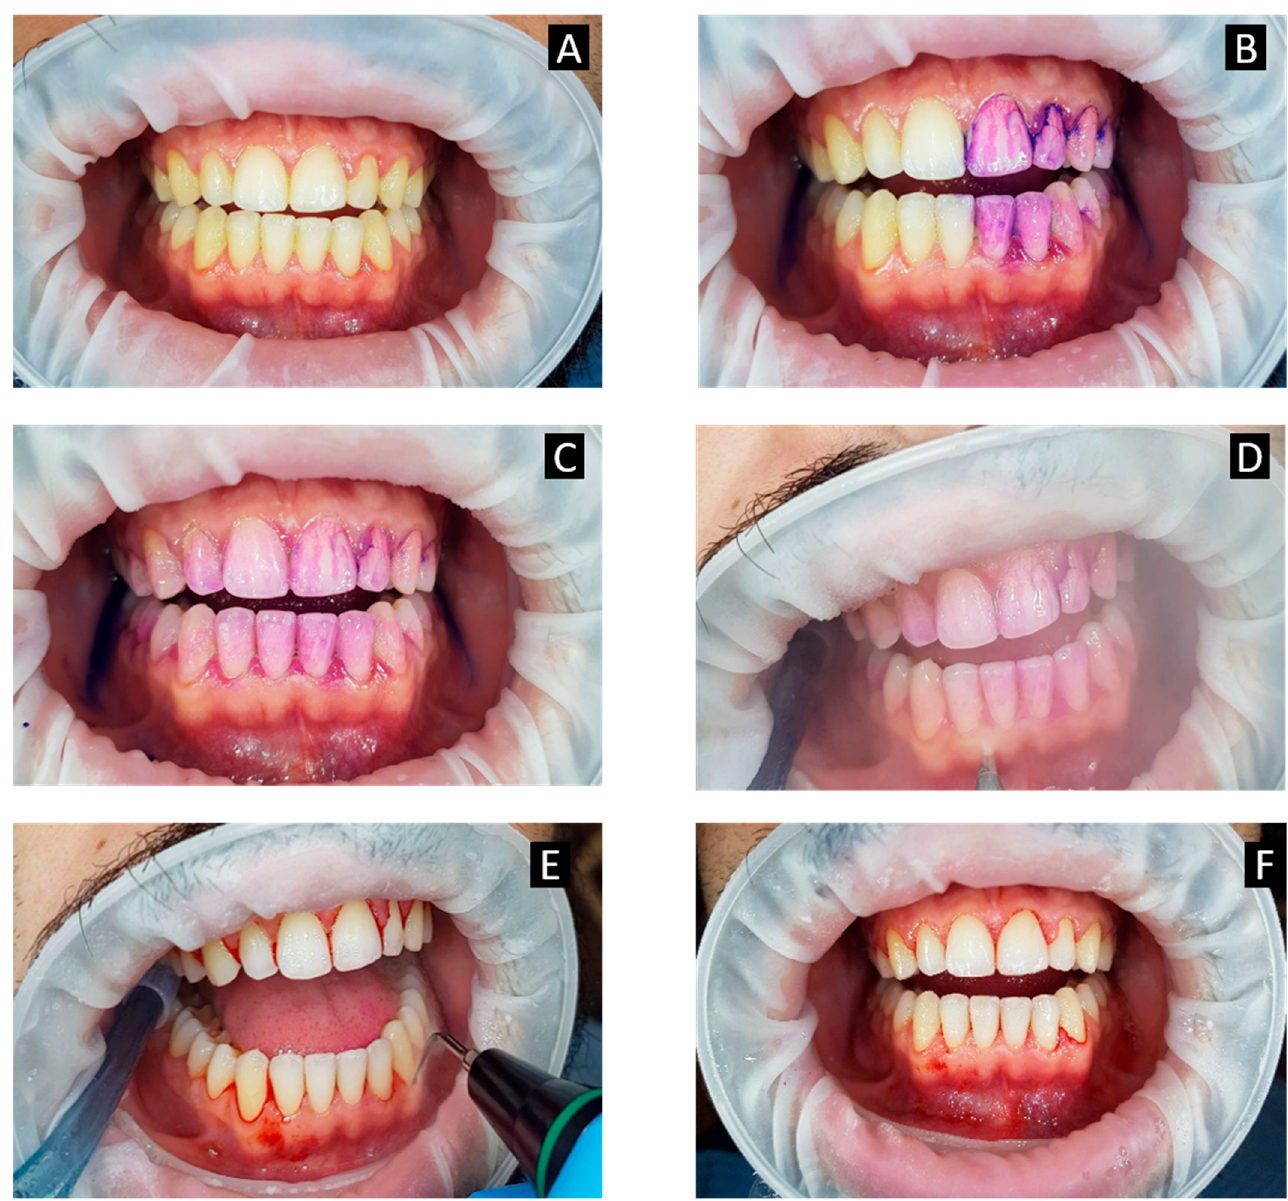
Figure 2. ( A – F ): Guided biofilm treatment (GBT) procedure in a patient with generalized bleeding on probing with plaque accumulation and localized calculus. ( A ) Pre-operative view; ( B ) application of disclosing agent on left half of the patient’s mouth; ( C ) application of disclosing agent over the patient’s entire mouth; ( D ) removal of supragingival biofilm and stains with air-polishing device (AIRFLOW ® Handy); ( E ) removal of the calculus removal from natural teeth with PIEZON ® PS allows thorough cleaning; ( F ) immediate post-operative view of the patient’s mouth after implementing the GBT protocol.